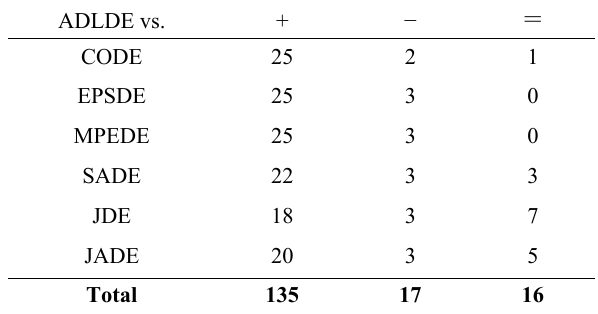
Table 9 Summary of function error values when D =